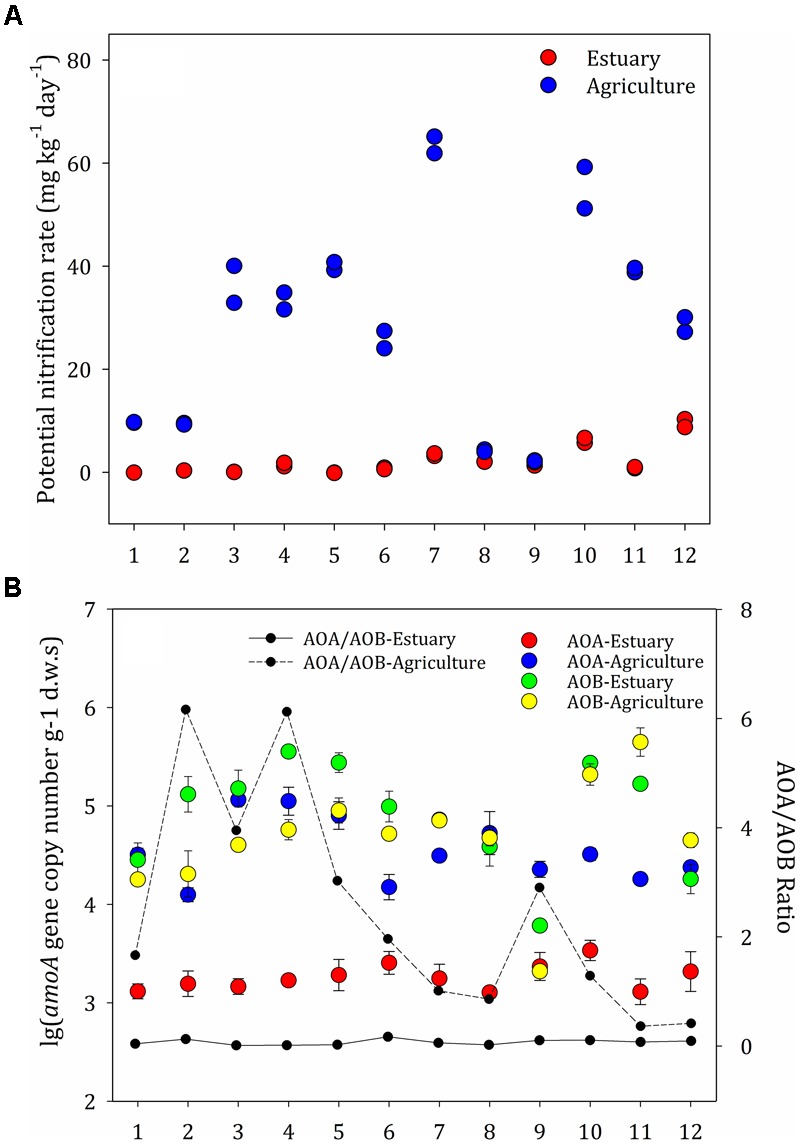
(A) Potential nitrification rates at the mudflat and agricultural sites. (B) Abundance of ammonia-oxidizing archaea (AOA) and ammonia-oxidizing bacteria (AOB) along the mudflat and at the agricultural sites based on the amoA copy numbers per gram dry weight of soil. The ratios of AOA to AOB amoA gene copies are shown as black (mudflat samples) and dotted (agricultural samples) lines. The error bars indicate the standard deviation.